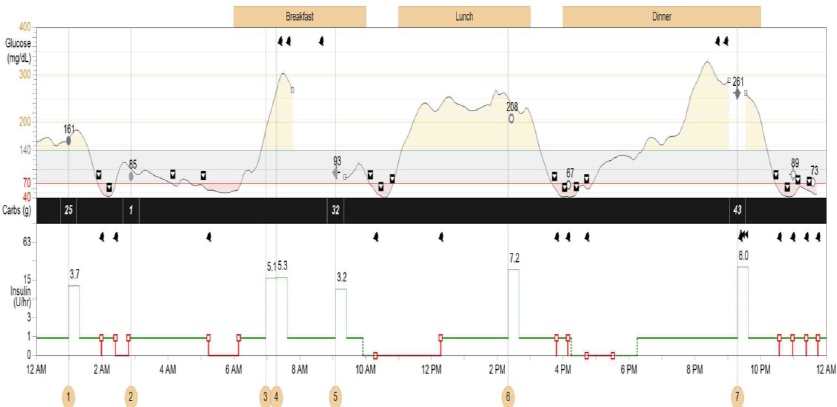
Figure 9. Download from a 530G Medtronic insulin pump with continuous glucose sensor (Enlite) and “Threshold Suspend” feature. The upper tracing shows multiple episodes of hypoglycemia with corresponding automatic suspension of insulin delivery (lower line) secondary to sensor-detected hypoglycemia.